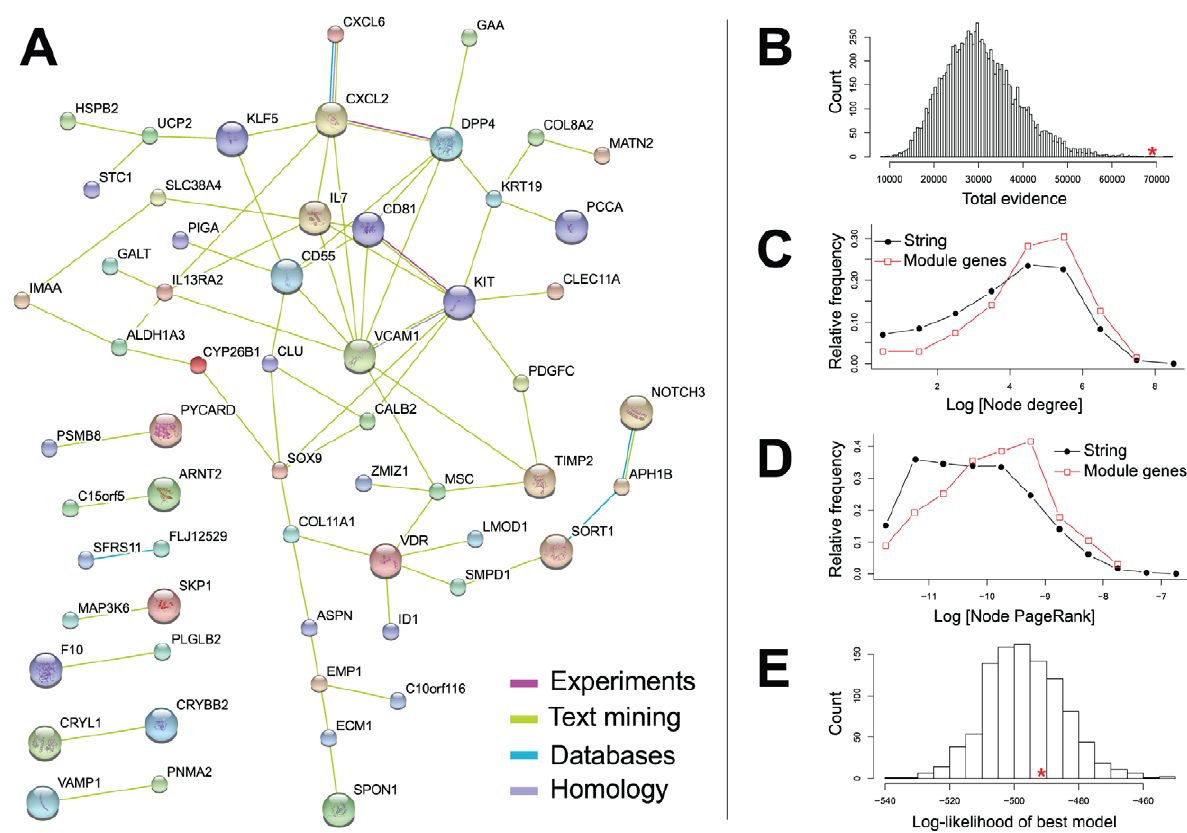
Figure 4. The network of the most frequent genes in the modules, as a subset of the STRING protein interaction database. Only genes that appear at least ten times in the dysregulated modules are considered. ( A ) Most frequent module genes that have at least one connection in the STRING database. Edges with evidence score higher than 0.3 are shown; their colors indicate different kinds of interaction evidence (key bottom right). ( B ) Most frequent module genes form a network that is denser than a random subnetwork of the same size in STRING. We generated 10,000 random subnetworks and calculated the sum of the evidence for all edges. Only five out of all random subnetworks show a higher total evidence value than the most frequent module genes indicated by a red asterisk (sum of total evidence=69,033). ( C ) Distribution of the number of connections (node degree) per protein in the complete STRING network (black, filled circles), and the subnetwork of most frequent module genes (red, open squares). The subnetwork has significantly less low-degree nodes and more high-degree nodes (Wilcoxon-test P =1.612 6 10 2 5 ). ( D ) Distribution of PageRank centrality scores in the complete STRING network and the subnetwork of most frequent module genes. The subnetwork has fewer non-central nodes and more central nodes (Wilcoxon-test P =2.628 6 10 2 5 ). ( E ) We fitted hierarchical models [60] to the subnetwork of the most frequent module genes, and also to 1,000 randomized networks. The network of frequent module genes (red asterisk) shows no hierarchical structure compared to the randomized